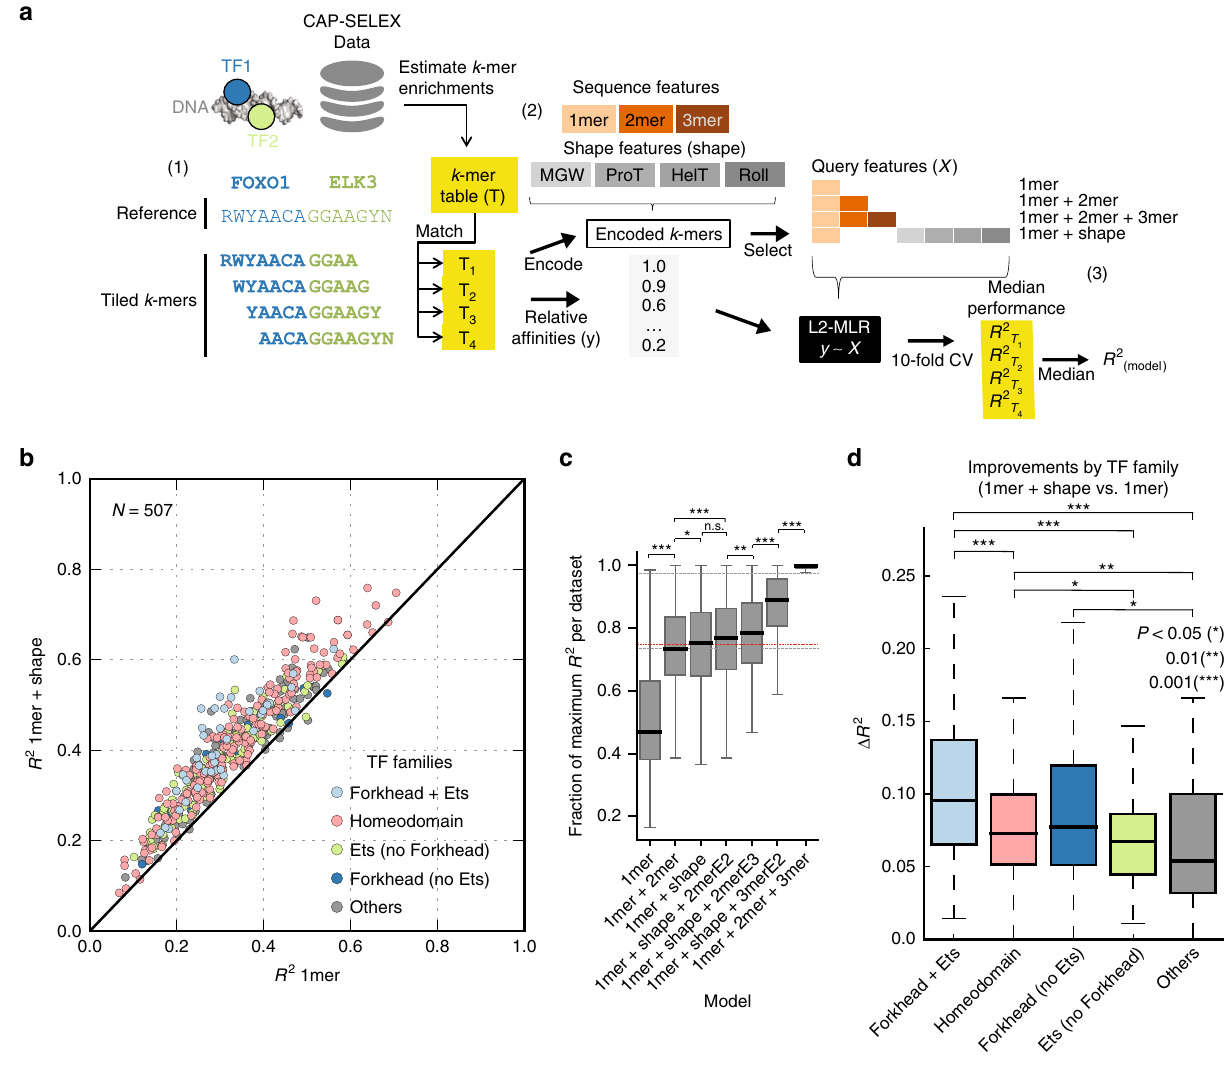
Fig. 1 Addition of DNA-shape features improves combinatorial binding predictions in CAP-SELEX data. a (1) Description of trim-and-summarize approach to obtain relative af fi nities for composite motifs ( k -mers): a reference k -mer from CAP-SELEX data is trimmed from either side into multiple tiled k -mers with lengths no shorter than ten (blue regions assigned to consensus sequence for FOXO1 in reported k -mer, green regions assigned to ELK3 consensus sequence in reported k -mer) (2) L2-regularized multiple regression model (L2-MLR) are generated using DNA features as predictors and relative af fi nities as response variables (see Methods section). DNA sequence features ( 1mer , 2mer , 3mer ) and DNA shape features (MGW, ProT, HelT, Roll), are tested in different combinations to assess their prediction contributions (3) A consensus improvement for each reference k -mer and model is obtained by cross-validation in each tiled k -mer table (10-fold CV) and calculation of the median tiled k -mer R 2 improvement for all cases. b Trim-and- summarize testing R 2 values are shown for each CAP-SELEX and reference k -mer combination, using tiled k -mers. Values above the diagonal indicate improvements in the testing set prediction performance when using mononucleotide and shape features together ( 1mer + shape , y -axis), with respect to models with only mononucleotide features ( 1mer , x -axis). Relevant TF family and TF family pairs are labeled by colors (Others = non-labeled families). c Fraction of maximum variance per R 2 dataset using different model con fi gurations. P -values and boxplots de fi ned as in d . d Trim-and-summarize Δ R 2 differences between 1mer + shape versus 1mer, strati fi ed by family (IQR = Q 3 − Q 1; whiskers = 1.5 × IQR) ( p indicates Wilcoxon test p -adjusted values, corrected by Benjamini Hochberg ’ s procedure 56